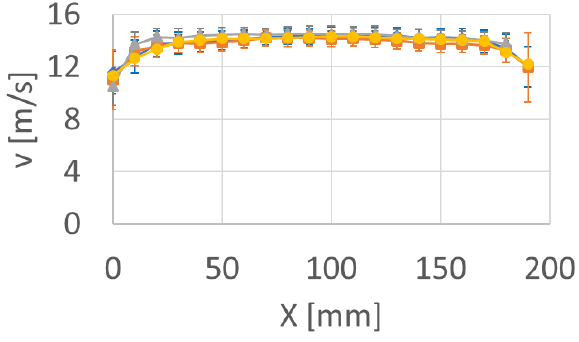
Fig 8. Velocity profile, mean velocity of 14 m/s .